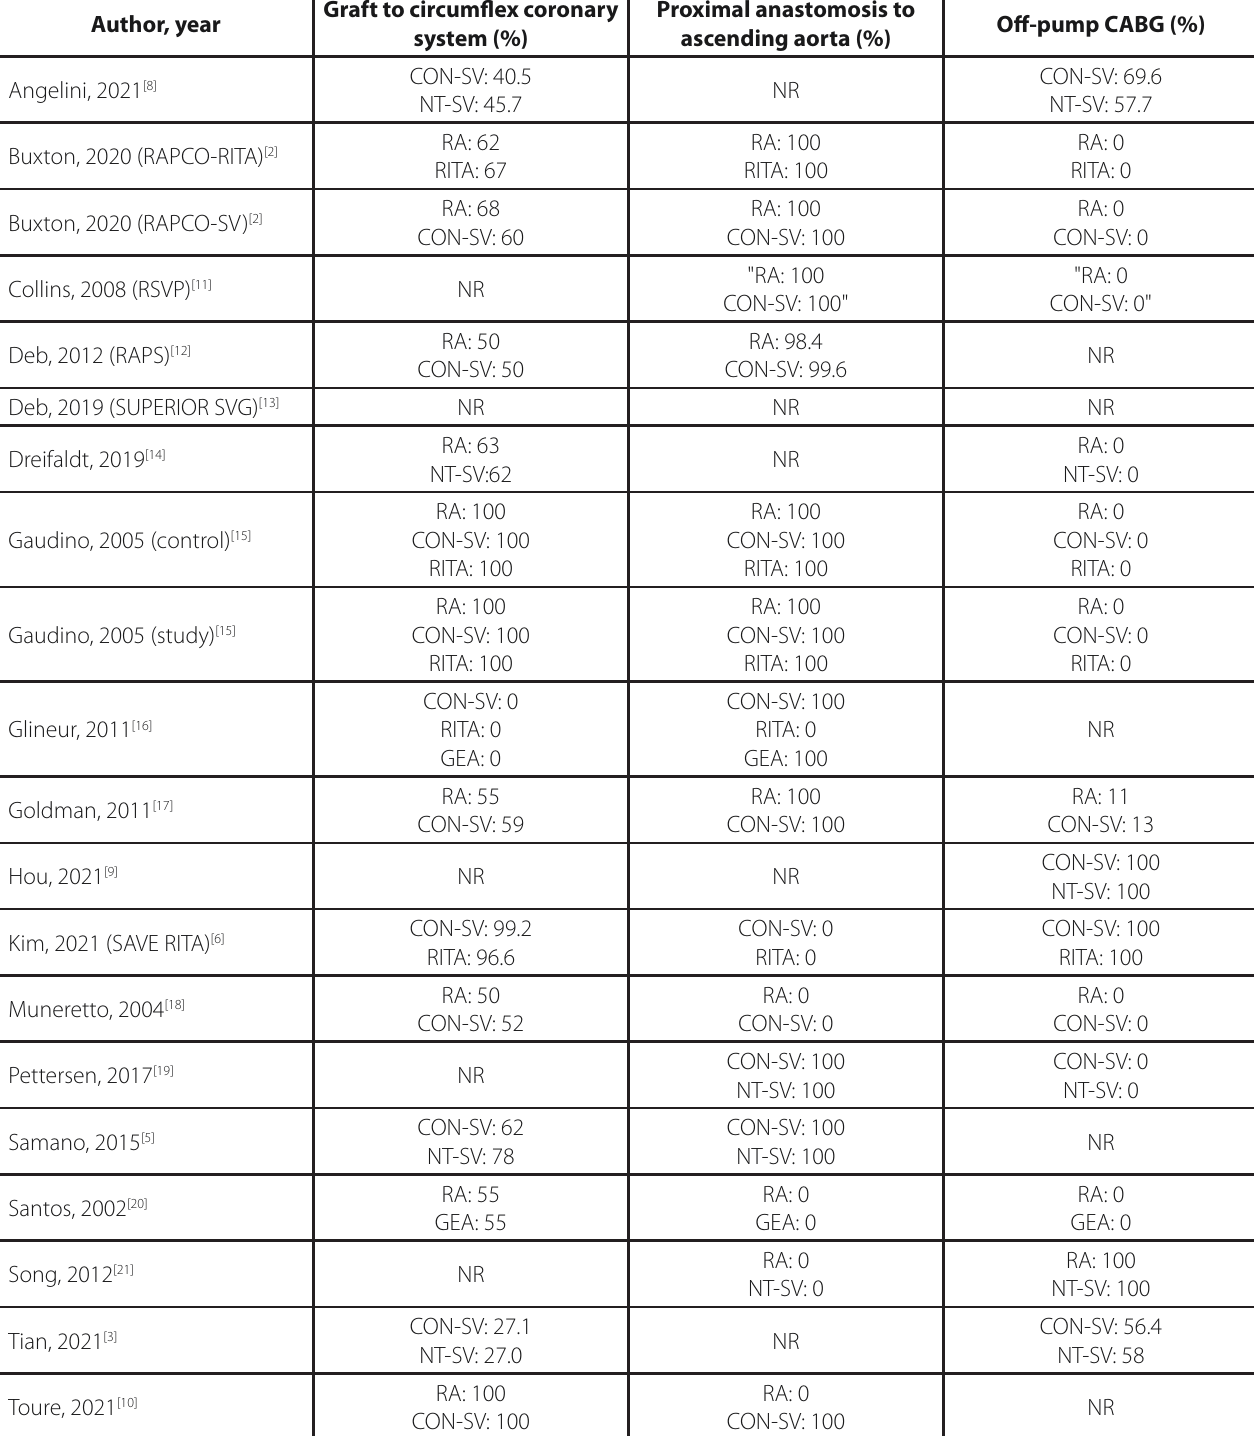
Table S4. Procedure-related variables by trial. Graft to circumflex Author, year